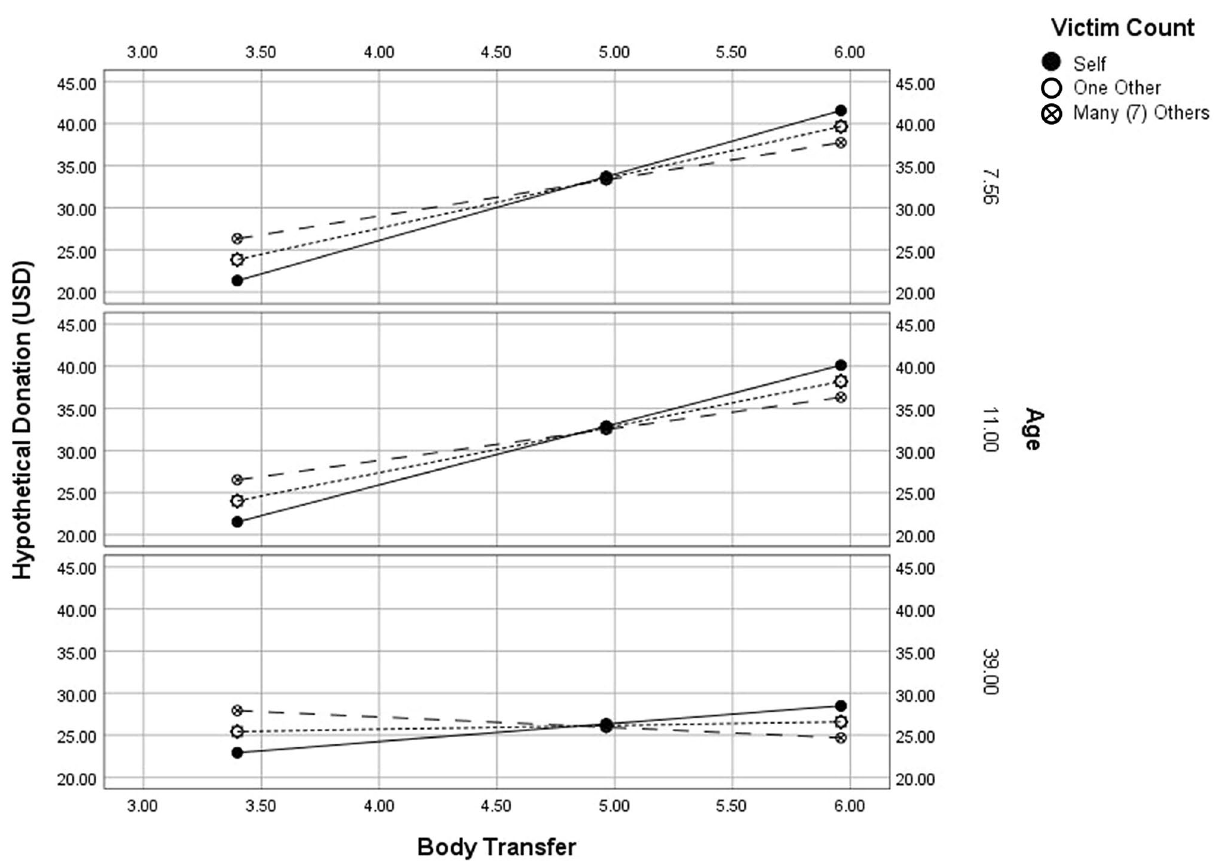
Figure 7. The differential effects of body transfer on donation amount as a function of age and victim count. Age significantly moderated the effects of body transfer on donation